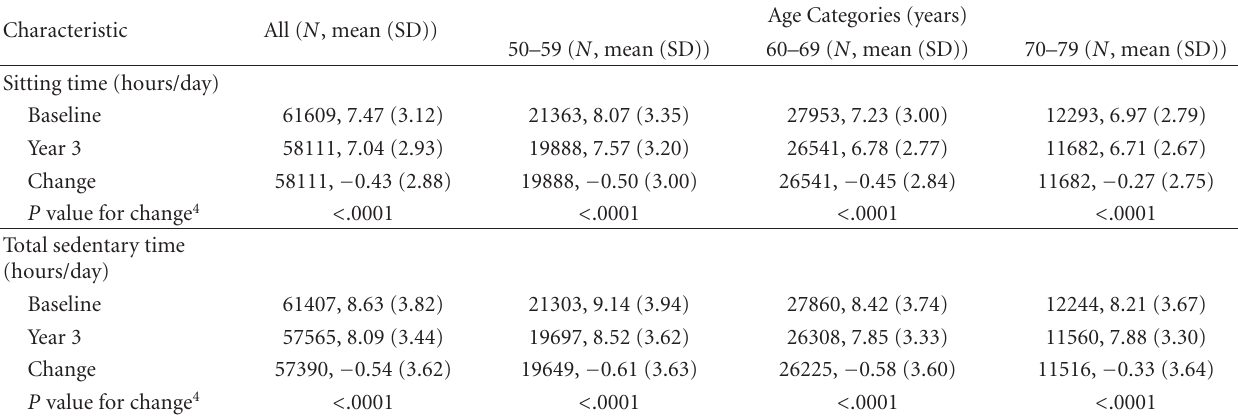
Table 2: Change in daily sitting time and total sedentary time between baseline and Year 3 of the OS, stratified by age.